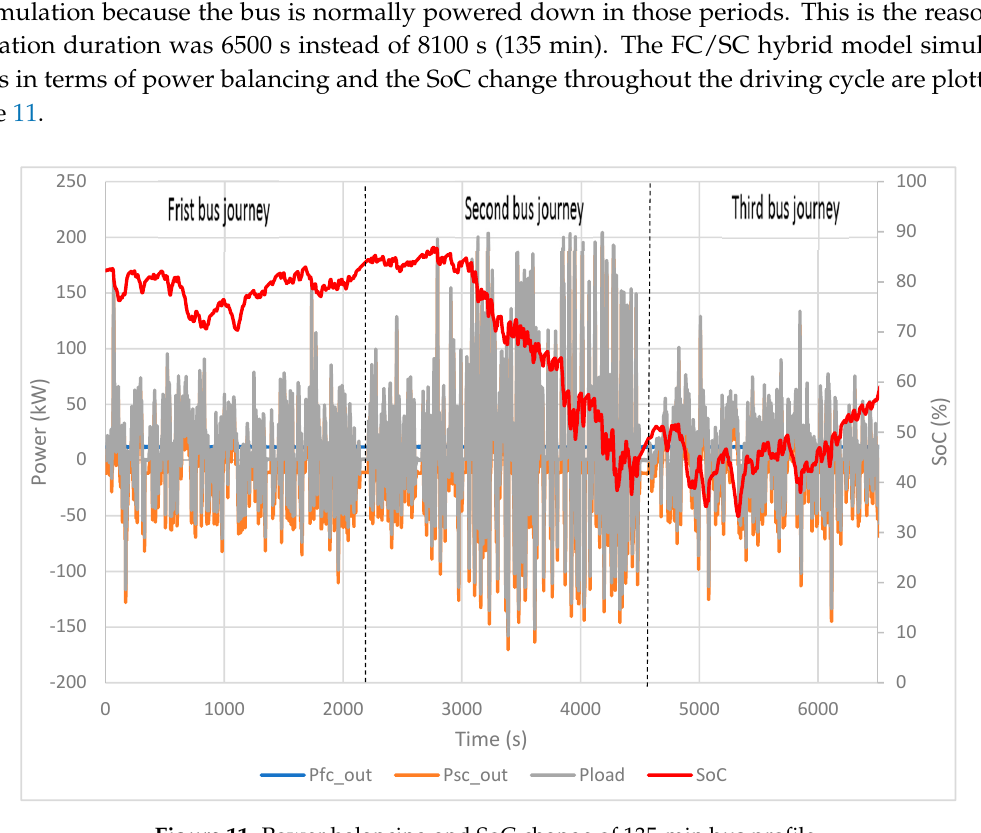
Table 2. First 135 min of route 388 24-hour bus profile parameters.